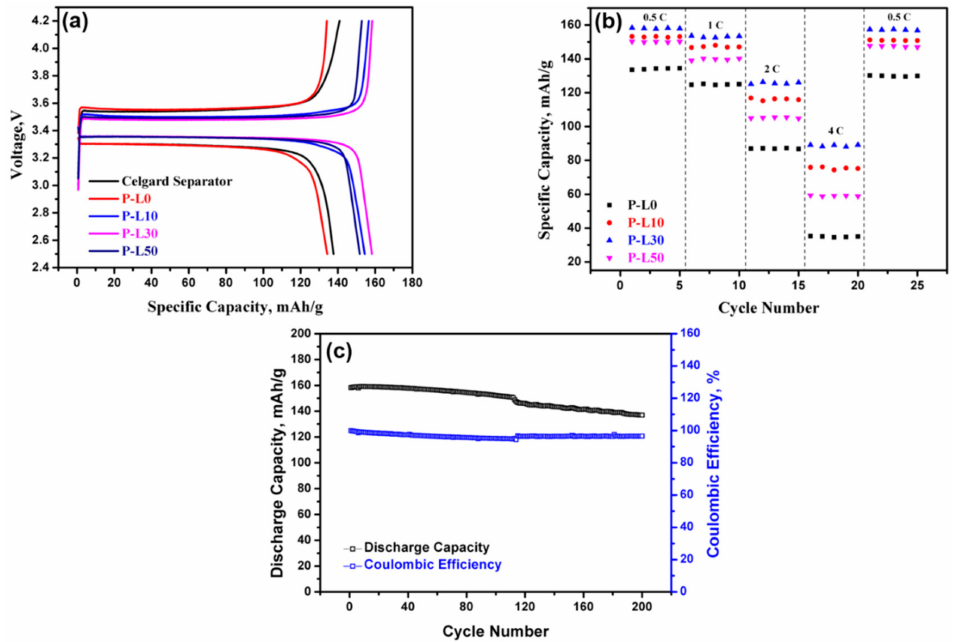
Figure 5. ( a ) Initial charge-discharge curve with 0.5C rate of PL membranes, ( b ) rate capability of PL membranes, and ( c ) cyclic stability and e ffi ciency of